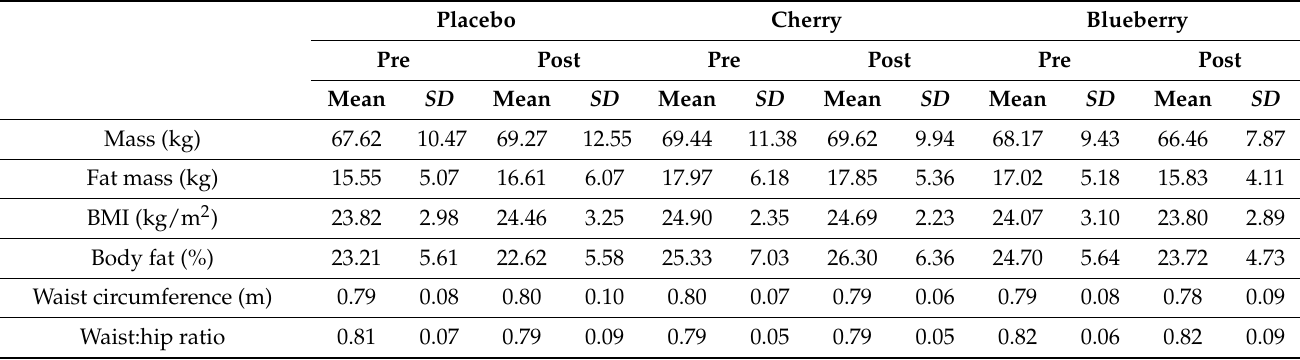
Table 3. Anthropometric measurements as a function of each trial